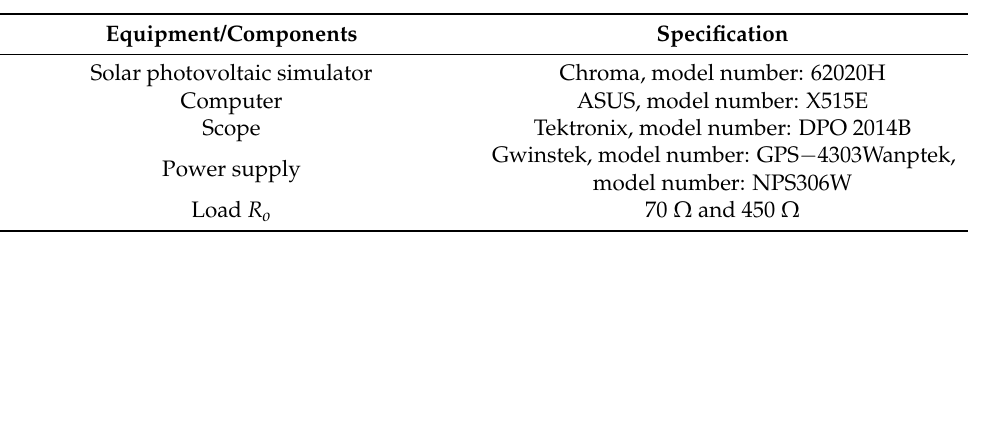
Figure 12. A prototype of the solar photovoltaic system.